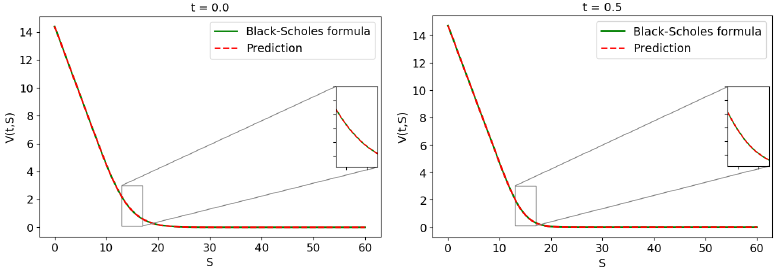
Figure 1. European put option for different times instances, t = 0, t = 0.5, with λ = 0.5.